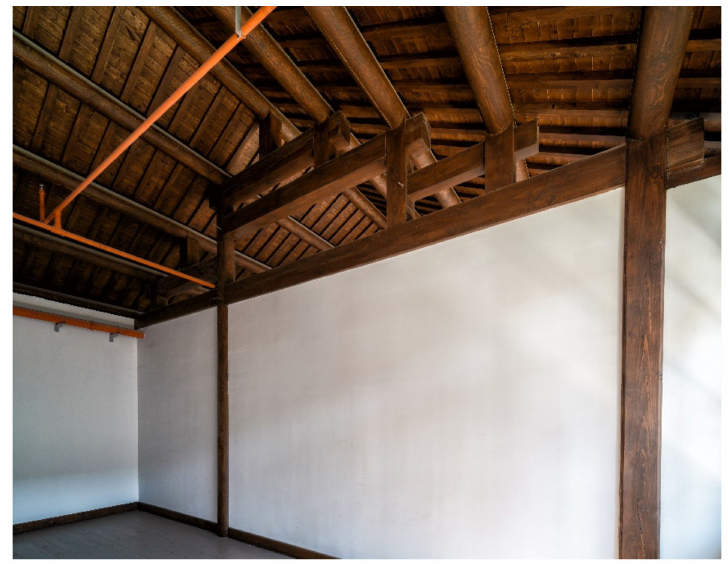
Figure 19. The traditional Chinese roof-truss system of “Tianbaoli”